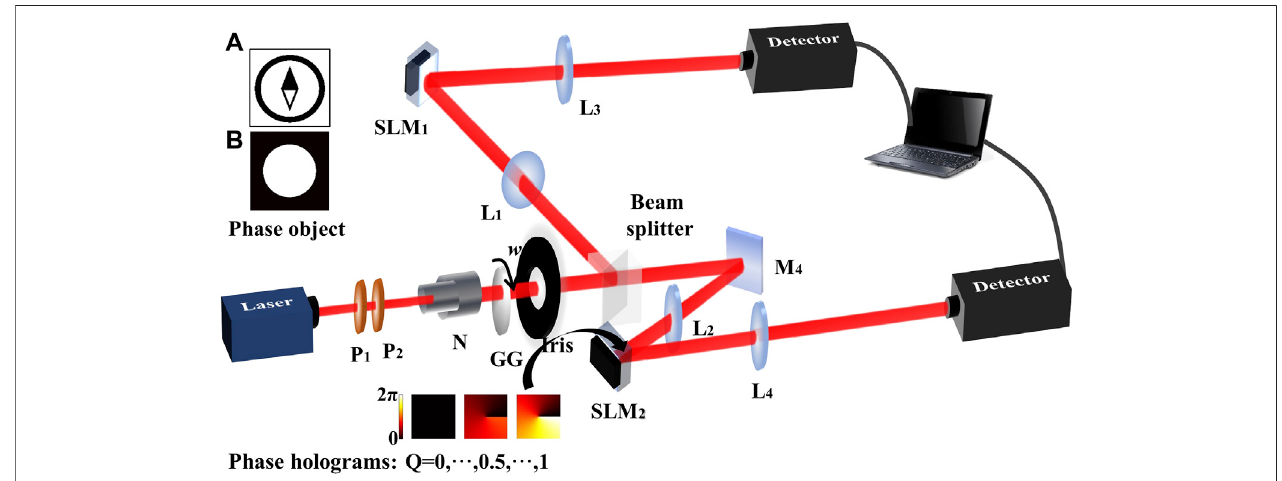
FIGURE1| Schematic diagram ofthe experimental setup.Phaseobjects inthe upper left corner are thesketchofa compass (A) and a circle (B) which areloaded by SLM 1, and the dynamic phase hologram in the lower left corner is loaded by SLM 2